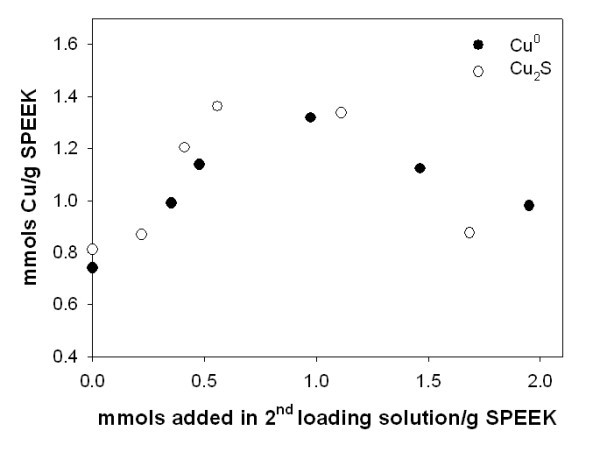
Total Cu and Cu2S content in nanocomposites versus Cu mmols and in 2nd metal-loading solution.